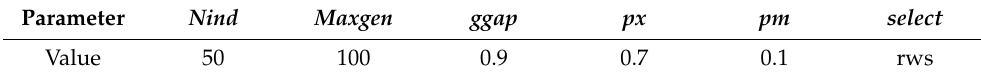
Table 8. The parameters related to the GA optimization algorithm.